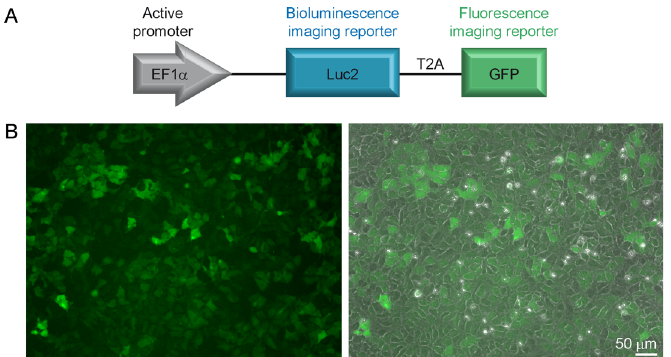
Fig 1. Newly generated hNSCs. (A) Schematic representation of the designed vector system. The two imaging reporters Luciferase 2 (Luc2) and green fluorescence protein (GFP) are kept under the control of the constitutive active promoter EF1 α and are linked via the T2A peptide sequence to ensure equal expression level of the two proteins. (B) Representative microscopic image of transduced and FACS sorted hNSCs. The overlay of the bright-field and fluorescence image is shown right. Scale bar: 50 μ